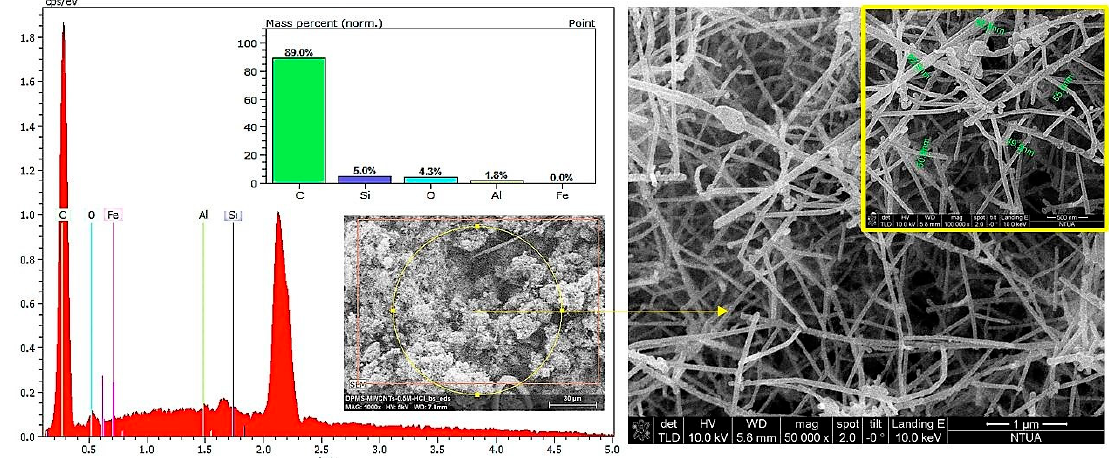
Figure 1. SEM images of the produced carbon nanofibers (CNFs) in (50,000× and 100,000× magnification) and an Energy Dispersive X-Ray Spectroscopy (EDS) analysis of CNFs for the purification assessment.